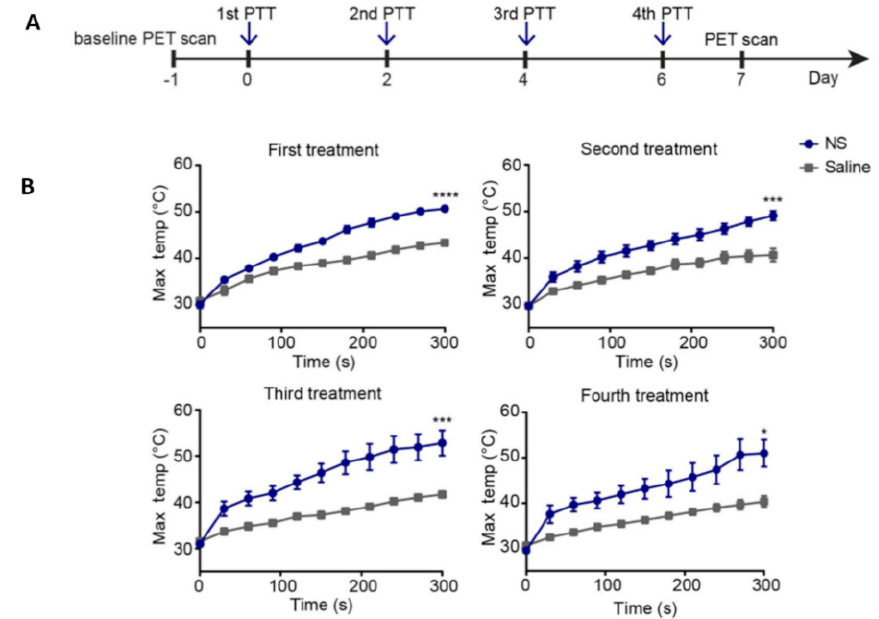
Figure 8. ( A ) The experimental timeline consists of two groups receiving either NS or saline, which were laser-treated four times every other day. ( B ) Temperature increase during all four laser treatments in treatment and the control groups. * p < 0.05, *** p < 0.001, and **** p < 0.0001. Adapted with permission from